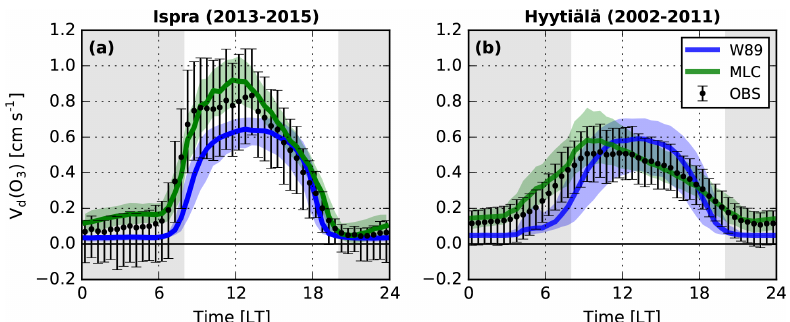
Figure 4. Diurnal cycles of April–September ozone dry deposition velocity at Ispra (a) and Hyytiälä (b) derived from observations (black) and simulations with the W89 parameterization (blue) and MLC-CHEM (green). Lines and points show median values, and shaded areas and whiskers display the interquartile range.